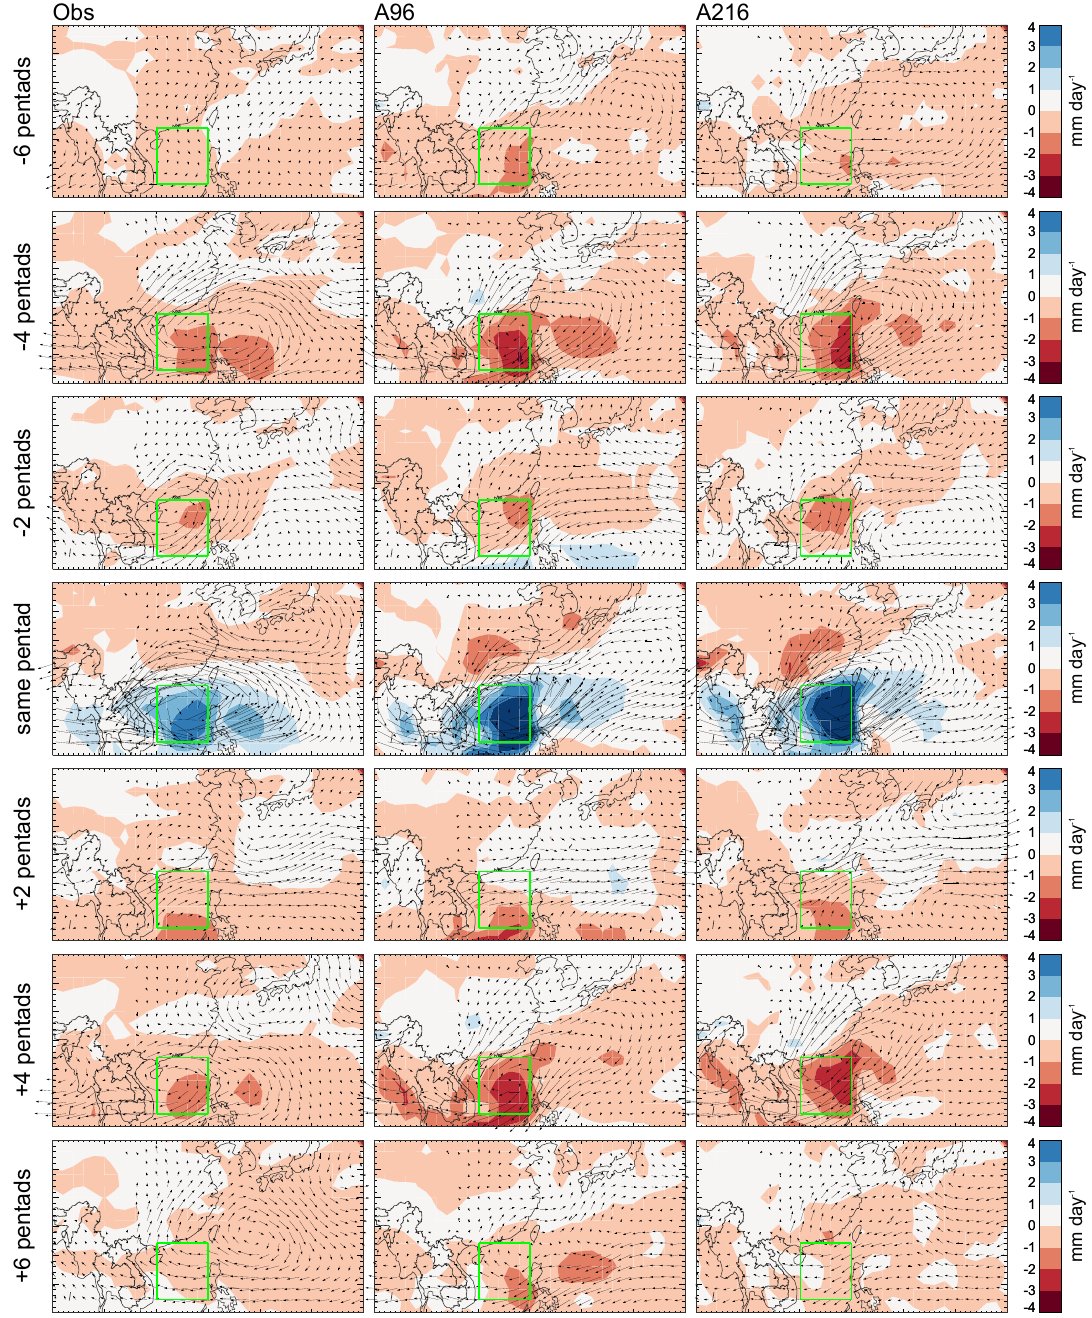
Figure 6. The regressed space–time evolutions of observed and simulated 20–70-day filtered precipitation and 850hPa wind with respect to the normalized pentad rainfall time series averaged in the South China Sea (green box; 12–22 ◦ N, 110–120 ◦ E). Wind arrows of 1ms − 1 correspond to 5 ◦ in latitude or